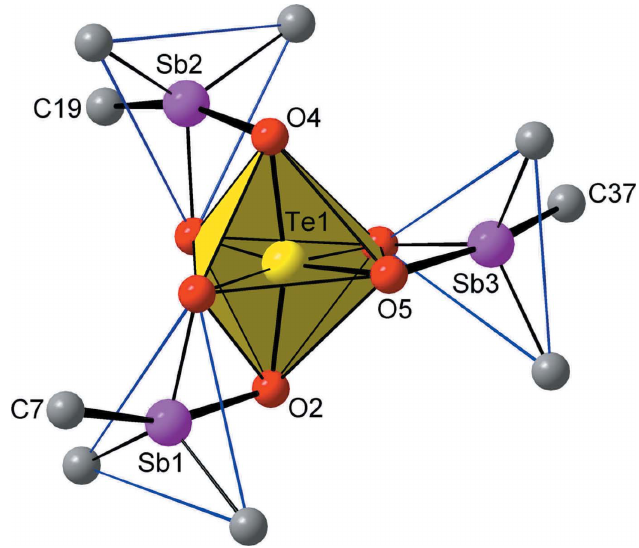
Figure 2 The connection of the Te- and Sb-coordination polyhedra, showing the mer -configuration of the [TeO 6 ] octahedron in the environment of three [SbC 3 O 2 ] trigonal bipyramids. The principal axes of the trigonal bipyramids are marked with thick black bonds and their equatorial planes are indicated by blue lines.